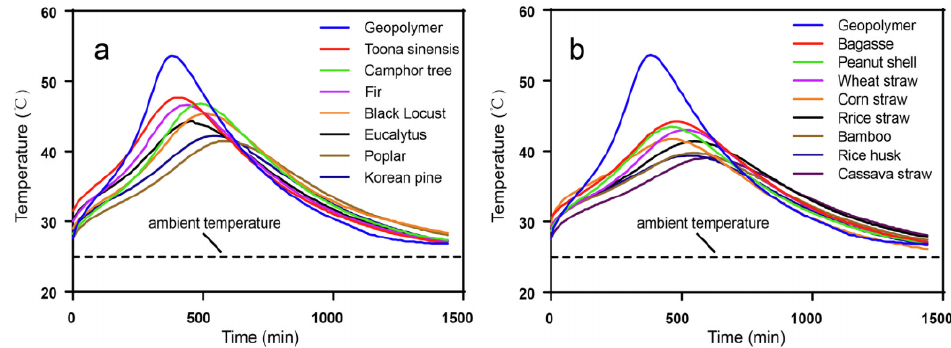
Figure 4. The geopolymerization temperature of PFRG as a function of time. ( a ) Wood fiber; ( b ) Non-wood fiber [78].